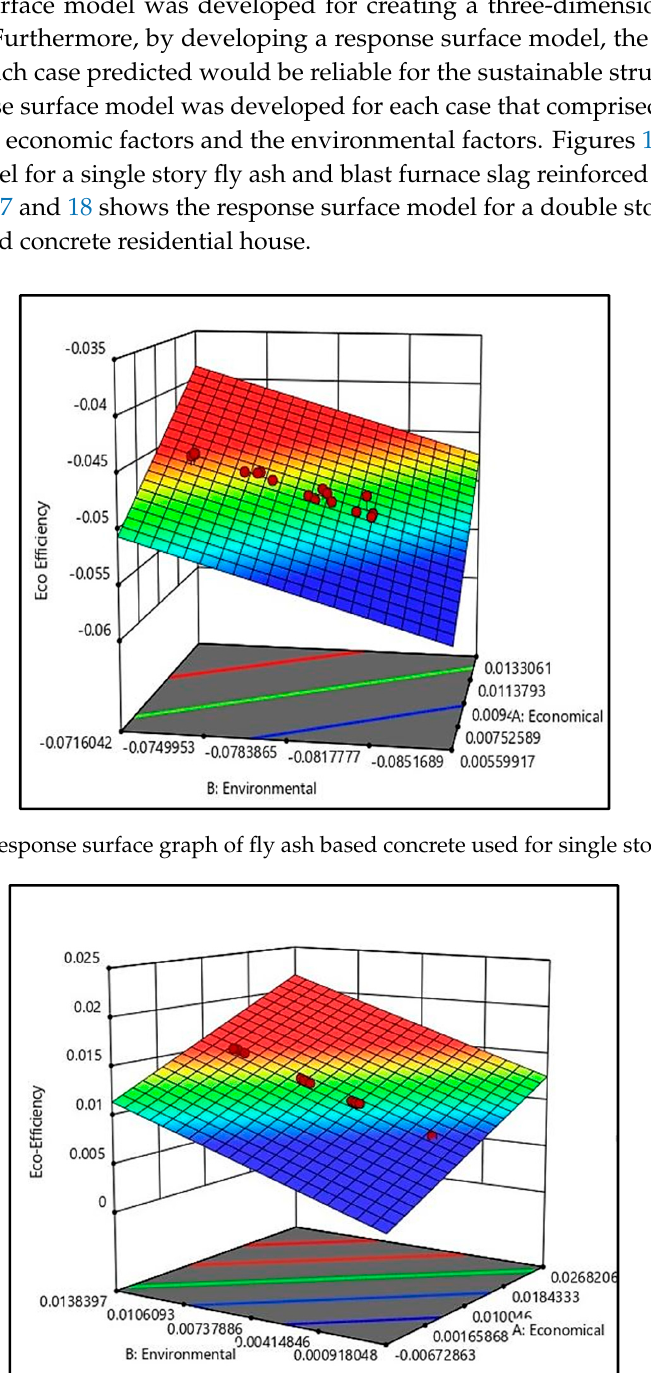
Figure 17. Response surface graph of fly ash based concrete used for double story houses. Figure 18. Response surface graph of blast furnace slag based concrete used for double story houses.